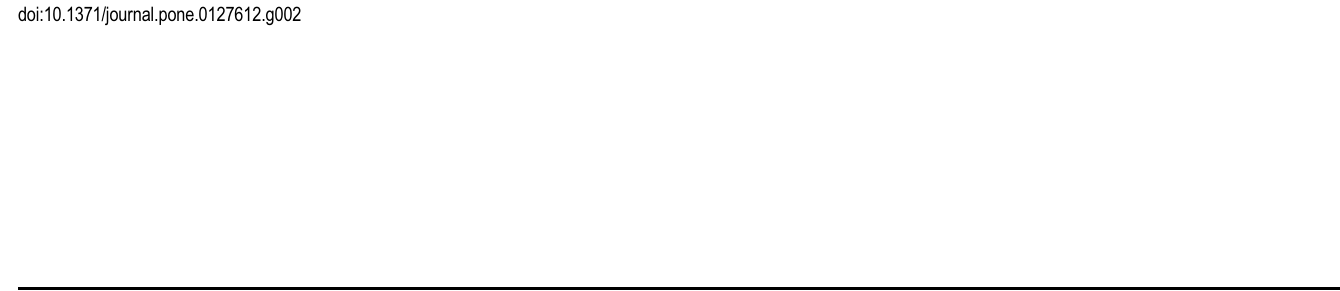
PLOS ONE | DOI:10.1371/journal.pone.0127612 July 8,